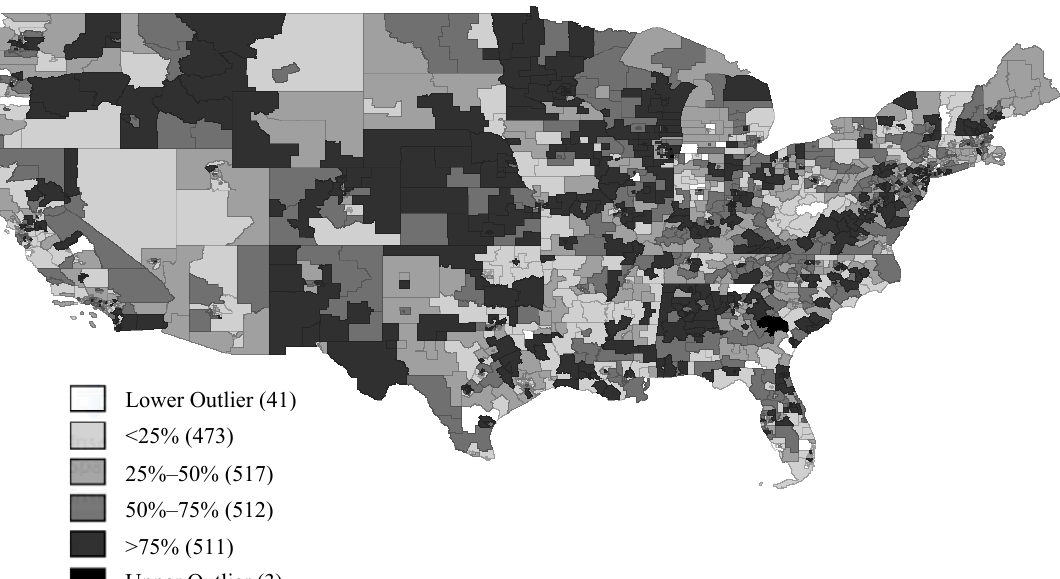
Figure 1. Boxmap of the distribution of married working